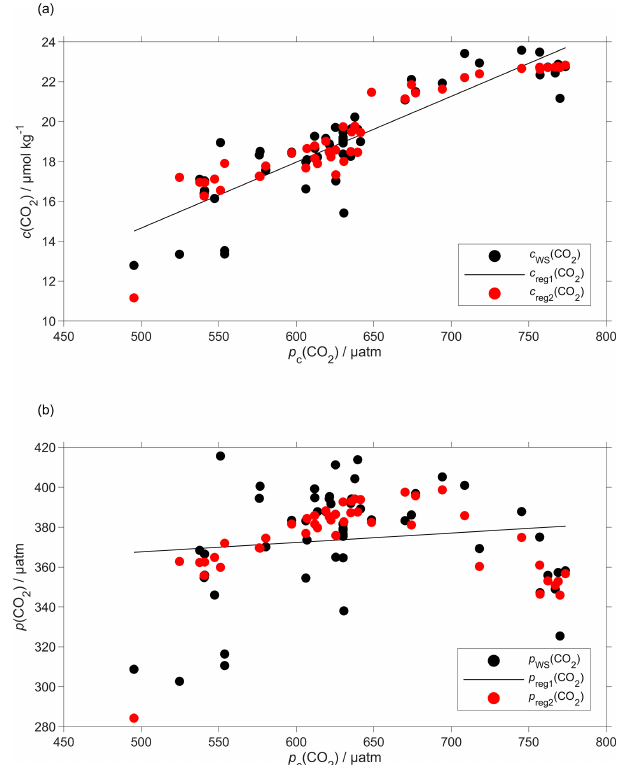
Figure 6. Regression (black lines, reg1) of the CO 2 optode output p c (CO 2 ) against (a) co-located concentration c WS (CO 2 ) that has an uncertainty of 0.28µmolkg − 1 (b) and partial pressure p WS (CO 2 ) of CO 2 in discrete water samples (black dots). Also shown are the values predicted by including θ and θ 2 in the regression used for optode calibration (red dots, reg2). The regression equations